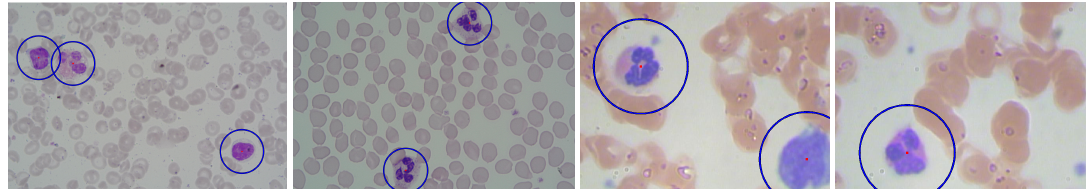
Figure 13. WBC detection results on two images extracted from IUMS-IDB ( left ) and two from SMC-IDB ( right ).